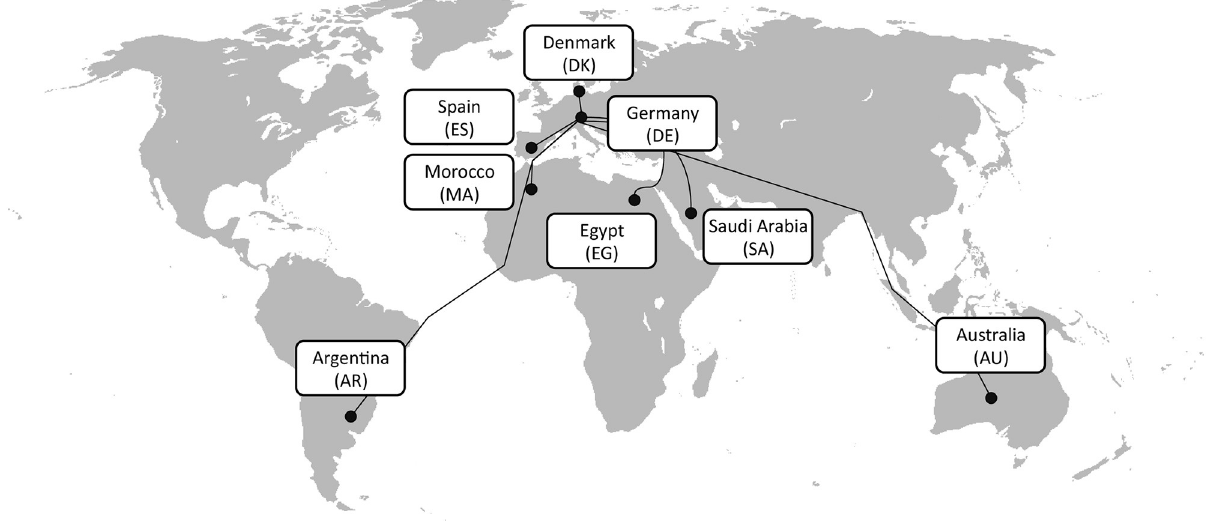
Fig 2. Countries considered for export. Exports of chemical energy carriers from countries shown to Germany (DE) are modelled and investigated for nine different Energy Supply Chains (ESCs).